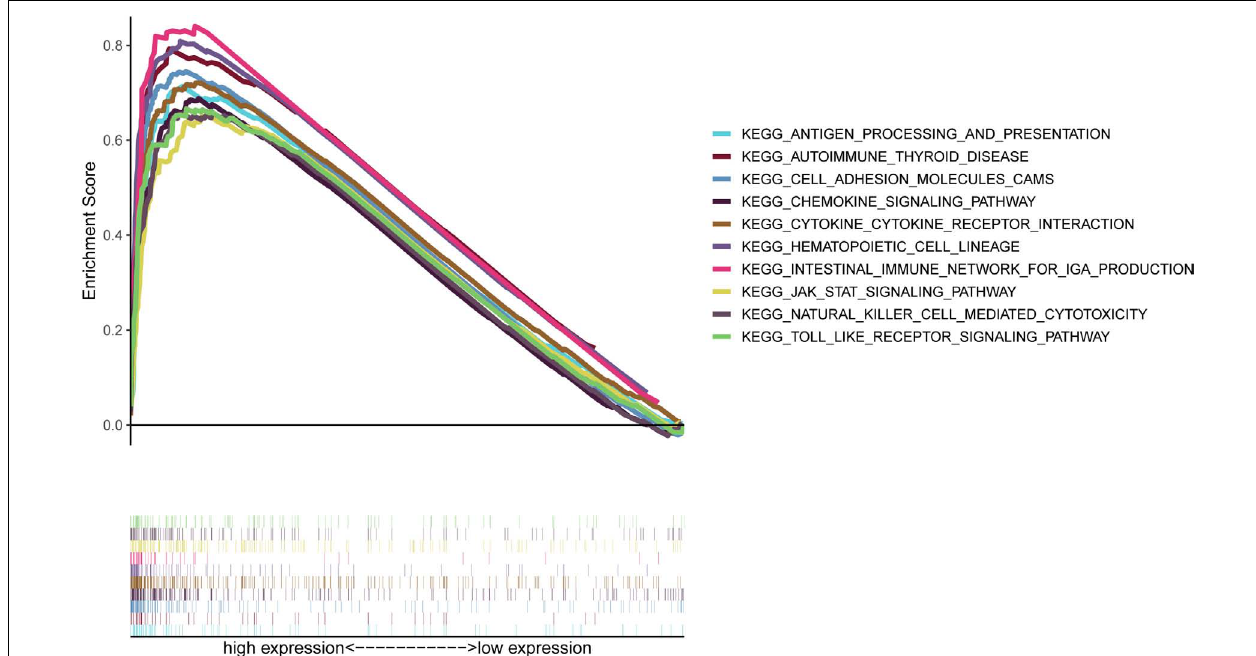
FIGURE 7 | Gene set enrichment analysis of CXCR4